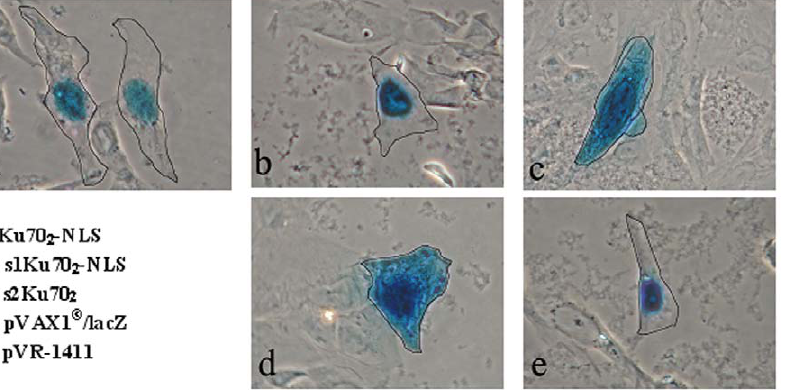
Figure 1. Intracellular localization of b -galactosidase fusion proteins. BEAS-2B cells were electroporated with 10 m g b -galactosidase coding plasmid DNA. All images show the typical blue b -galactosidase staining. Images (a) and (b) point that Ku70 2 -NLS and s1Ku70 2 -NLS show nuclear localization signal activity. The exclusive blue staining of nuclei is clearly visible. The s2Ku70 2 shows staining of the cytosol. The NLS large antigen (e) was used as positive control for nuclear localisation and b -galactosidase without NLS (d) as negative control.